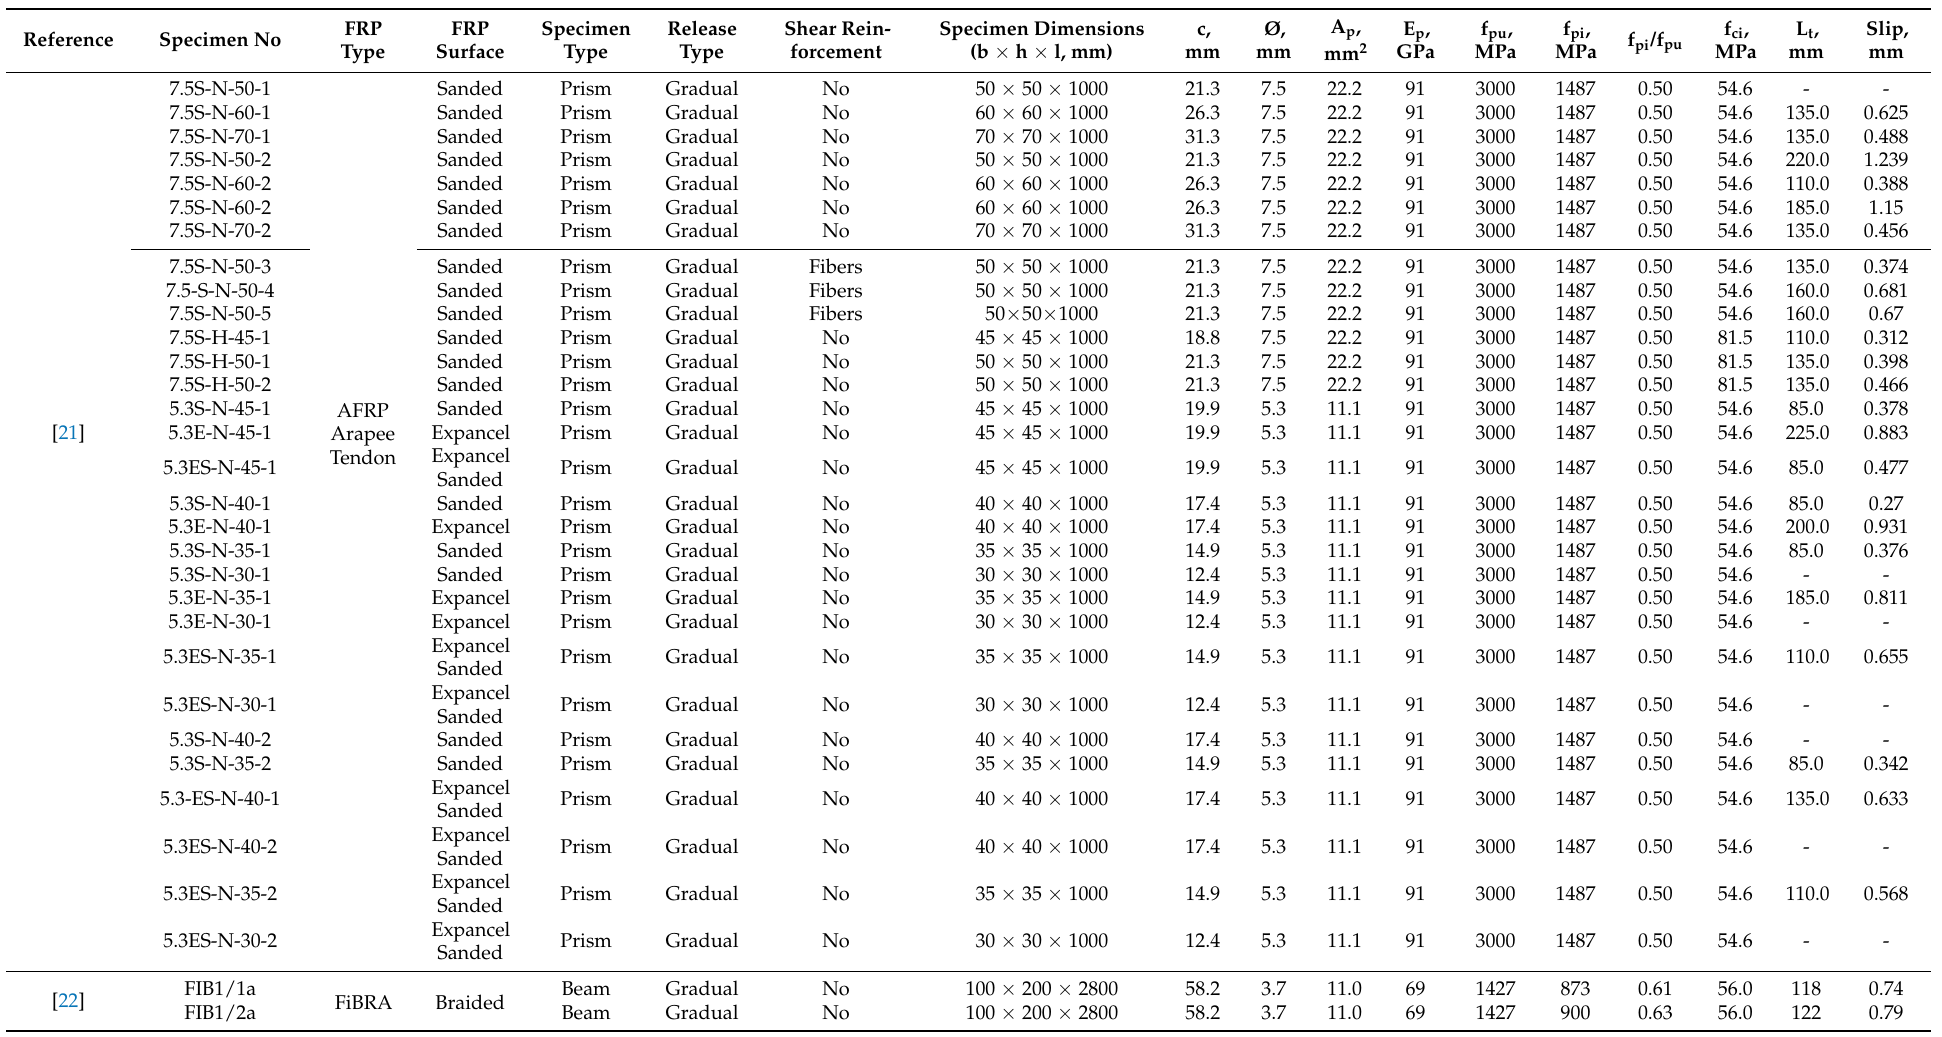
Table A3. Experimental parameters of specimens with pretensioned AFRP